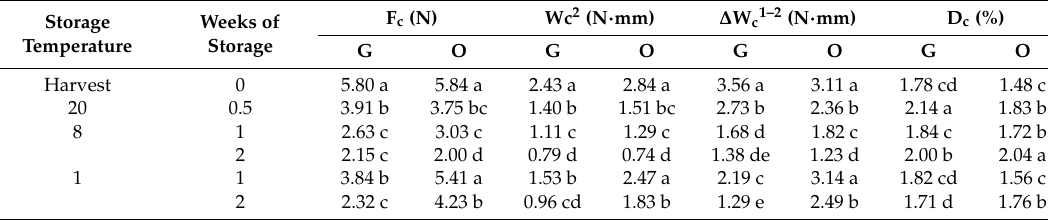
Table 3. Influence of storage temperature and duration on F c , W c2 , ∆ W c1–2 and D c . Means with the same letters in a column are not significantly different at p ≤ 0.05 in Fisher’s multiple range test. G: ‘Goldrich’ and O: ‘Orangered ®